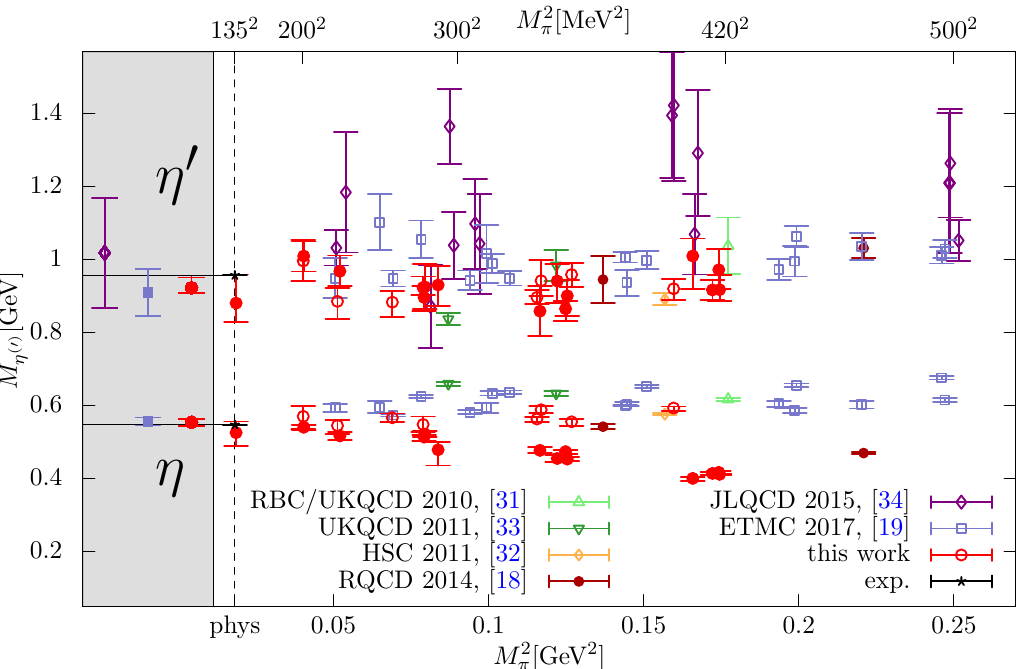
Figure 12. Recent N f = 2+1(+1) lattice results for the masses of the η and η 0 mesons. Most points have been simulated at approximately physical strange quark masses (open symbols), whereas in this work we also include an additional trajectory along which the average of the quark masses is kept constant (filled symbols). The three sets of points in the shaded regions left of the physical point (dashed line) correspond to the continuum and chirally extrapolated results of JLQCD [34] (who do not give an estimate of M η ), ETMC [19] and this